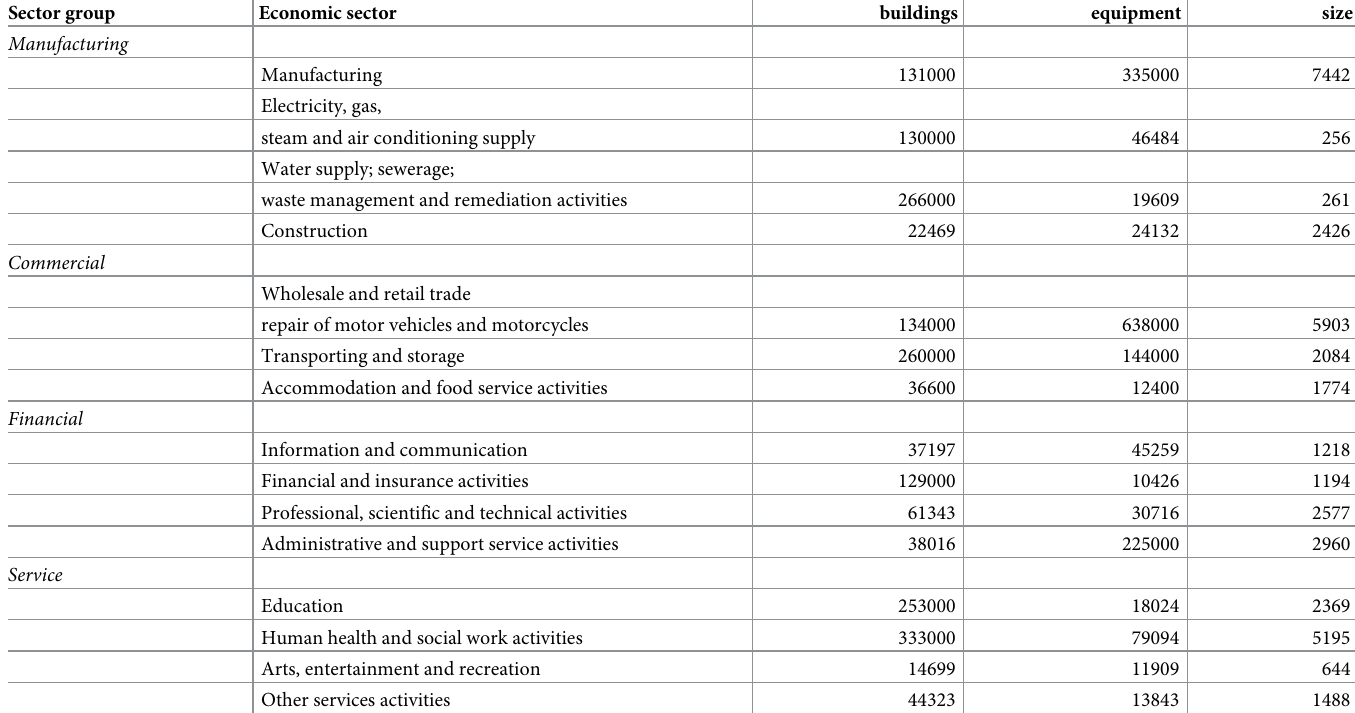
Table 1. Economic sectors and sector groups, net fixed assets (buildings and equipment) in millions of Euros and the size in thousands of employees for different economic sectors throughout all of Germany. Different damage models are applied to the four sector